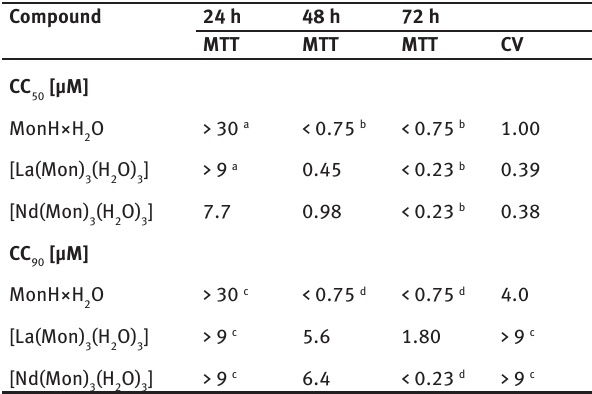
Table 3: Cytotoxic effect of Monensic acid and complexes 1 - 2 on LSR-SF-SR cell